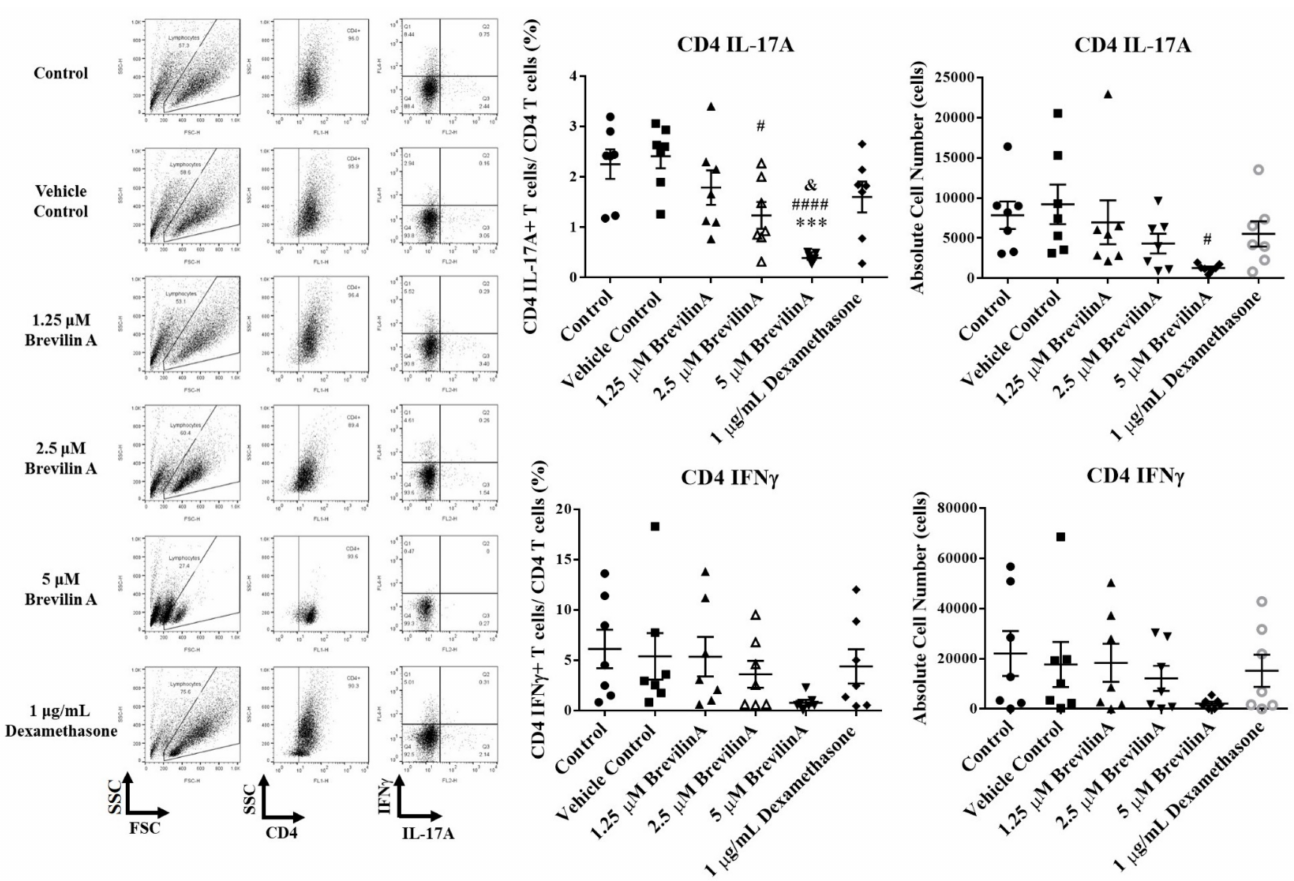
Figure 4. The effects of brevilin A on suppressing the Th17 differentiation of naïve CD4+ T cells from psoriasis patients. Naïve CD4+ T cells were isolated from PBMCs of psoriasis patients ( n = 7) and then stimulated with Th17 skewing condition and different doses of brevilin A for 4 days. Dexamethasone was used as the treatment control. Expressions of CD4, IFN- γ , and IL-17A were detected by flow cytometer; the results are expressed as the mean ± SEM. *** p < 0.005 vs. control group. # p < 0.05, #### p < 0.001 vs. DMSO group. & p < 0.05 vs. Dexamethasone